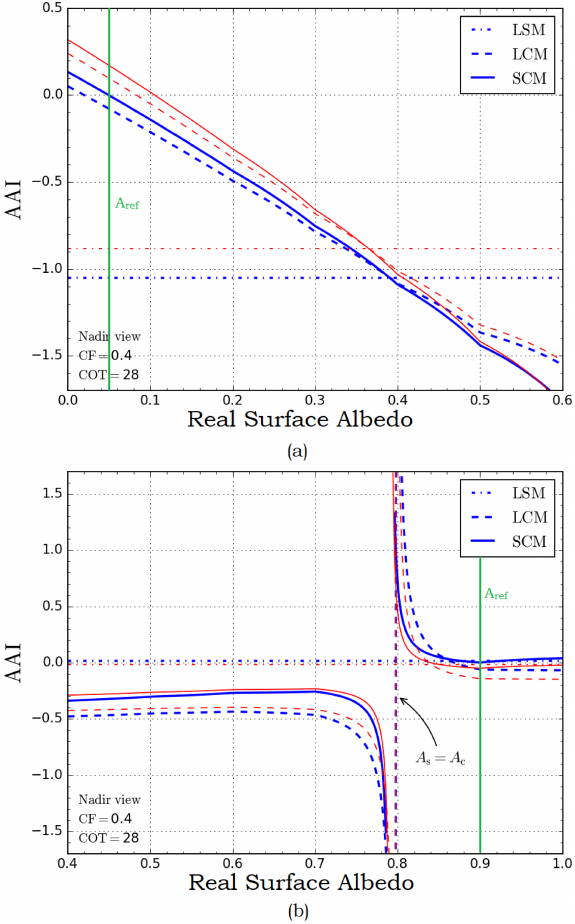
Figure 10. AAI sensitivity to errors in surface albedo for the LSM method (dash-dot), LCM method (dashed), and SCM method (solid) for HG clouds (blue) and Mie clouds (red). The green line shows the reference (expected) surface albedo of the scene. The hor- izontal axis shows the actual (real) surface albedo with panel (a) showing the sensitivity for low albedo scenes with A s = 0 . 05 and panel (b) for high albedo scenes with A s = 0 . 9. The scene has an effective cloud fraction of 40%.